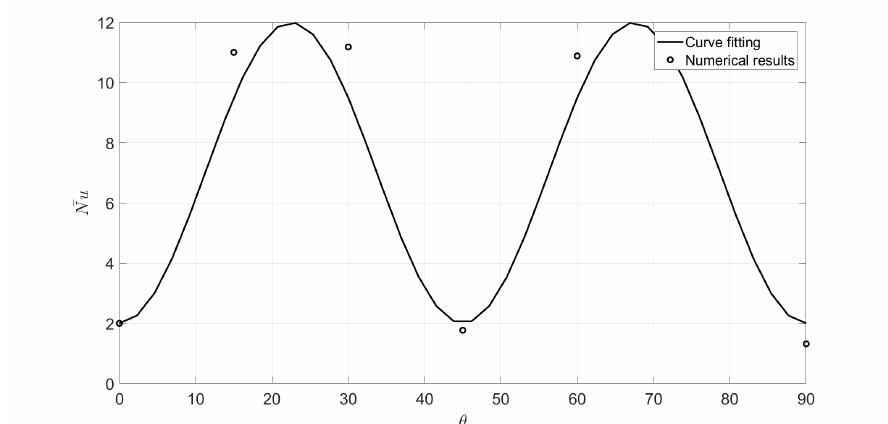
Figure 11. Effect of magnetic field angle on average Nusselt